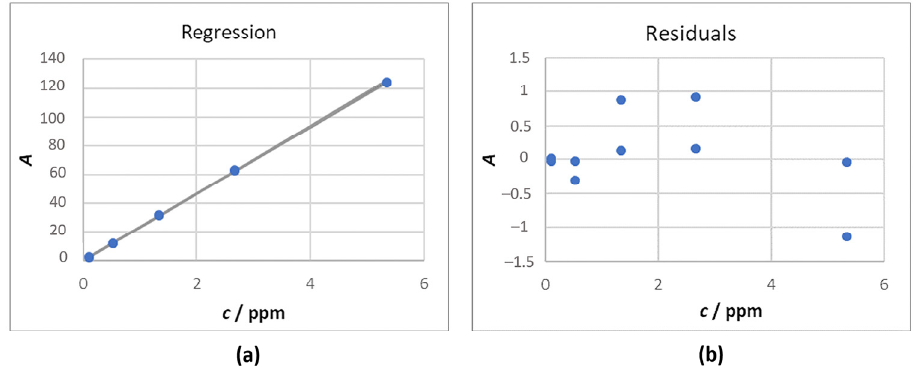
Figure 2. Calibration for TC: ( a ) Regression line obtained; ( b ) Residuals graph. The equation of the calibration curve obtained is reported in Equation (4).